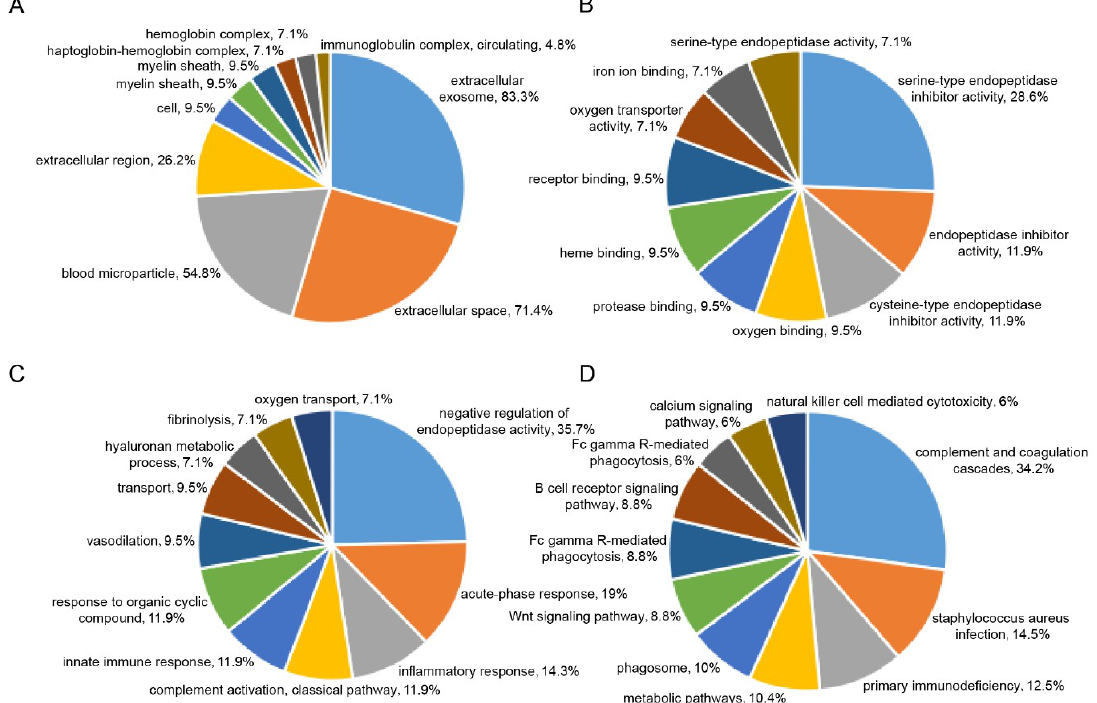
Figure 6. GO annotation analysis and pathway analysis of the differentially expressed proteins. ( A ) cellular compartments; ( B ) biological process; ( C ) molecular function; and ( D ) the most enriched pathways.